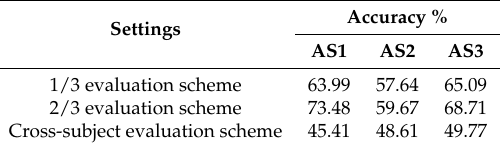
Table 8. Recognition accuracy in terms depth sequences of MSR 3D action dataset using pre-trained AlexNet network.